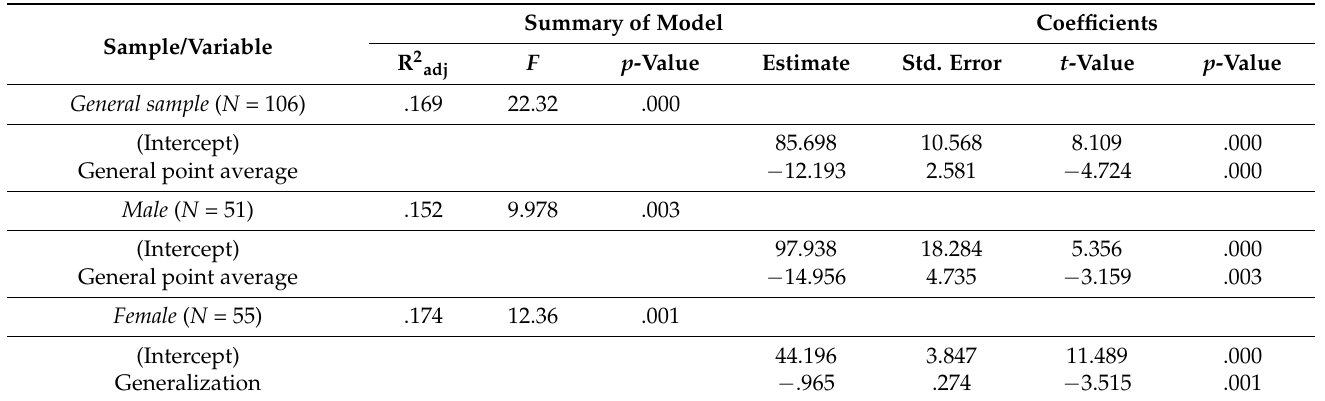
Table 7. Best predictor regression models for Absolutization subscale of